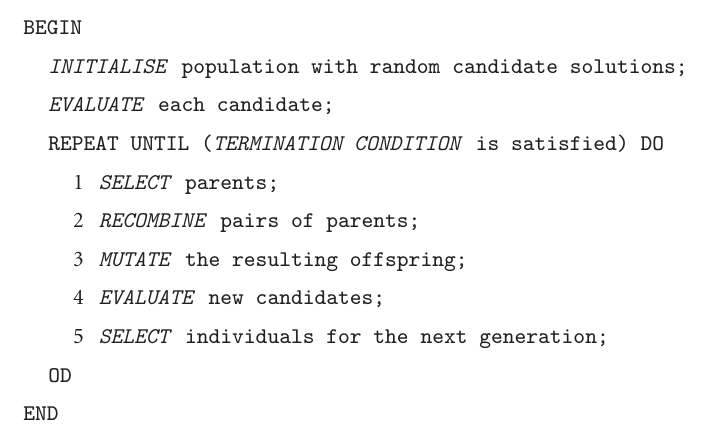
Pseudocode 1: The general scheme of an evolutionary algorithm in